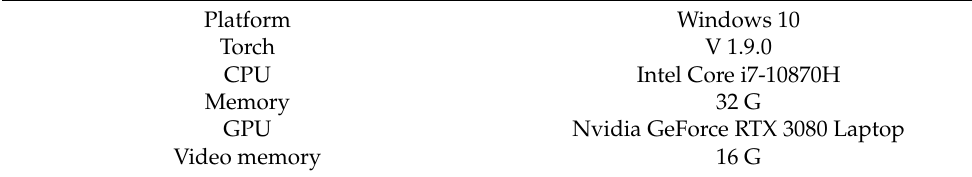
Table 1. The basic experimental environment